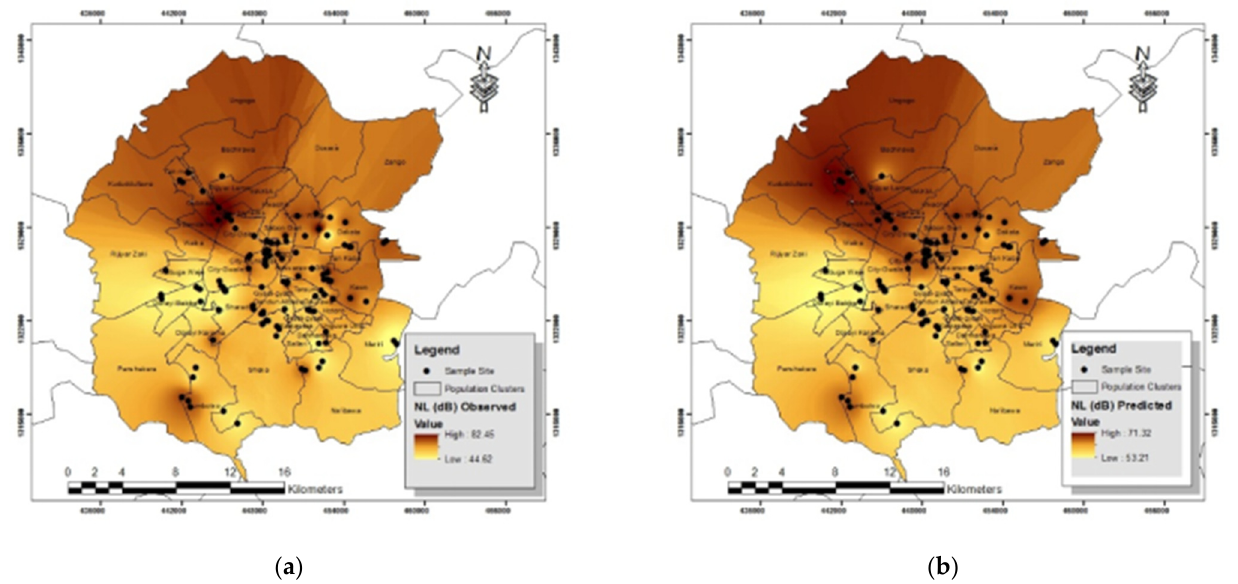
Figure 1. ( a ) observed noise and ( b ) predicted noise of Kano Metropolis.